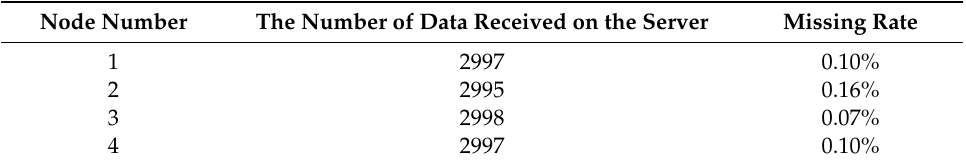
Table 3. The number of data received on the server.